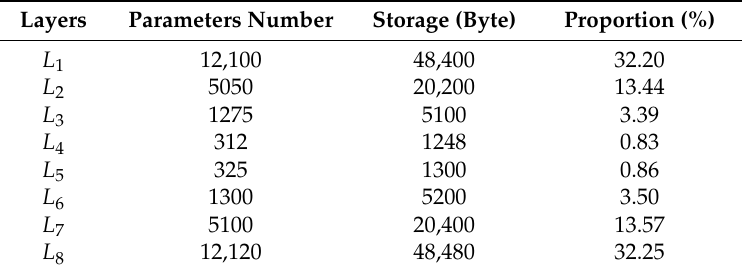
Table 3. The distribution of the Stacked RBM-AE model